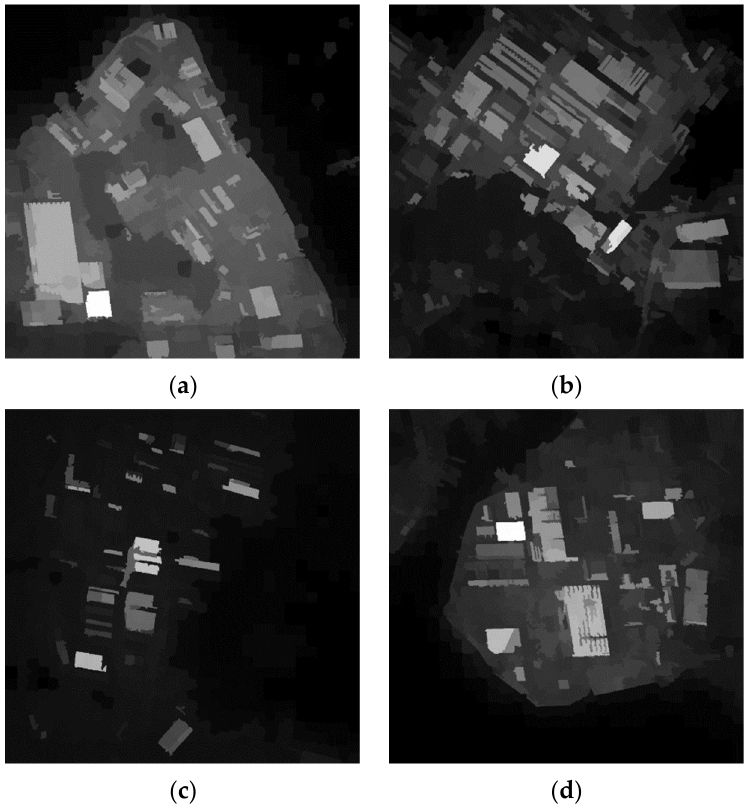
Figure 12. Foreground mask map overlaid with saliency detection result. ( a ) Image I, ( b ) Image II, ( c ) Image III, ( d ) Image IV.